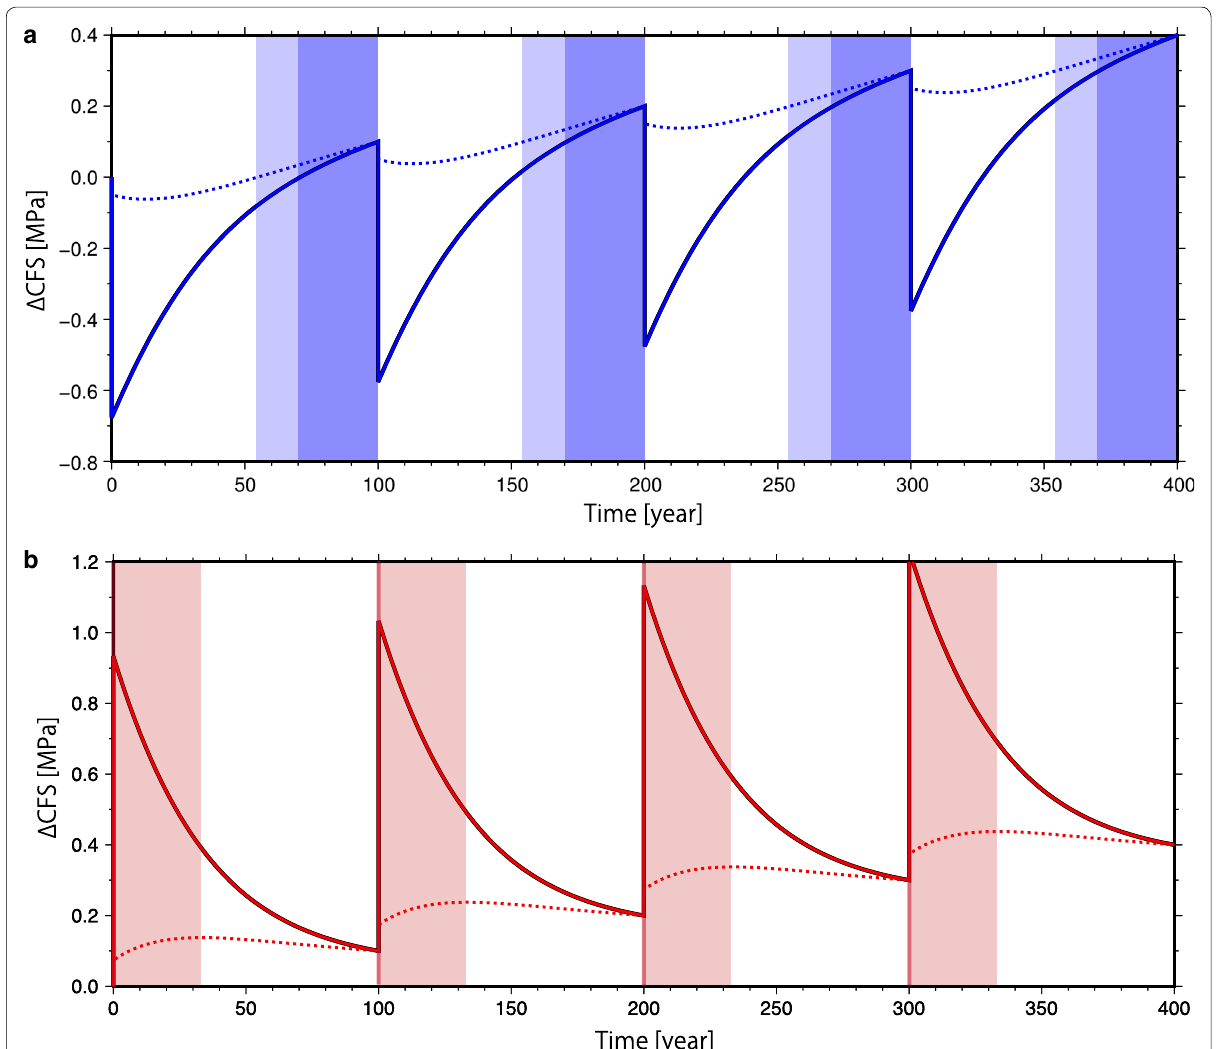
Fig. 3 Examples of the temporal evolution of (cid:31) CFS on an inland fault. The apparent coefficient ( µ ′ ) and the intrinsic loading rate ( �τ intrinsic s /year) in the inland fault are 0.1 and 0.5 kPa/year, respectively. a Case of negative coseismic (cid:31) CFS for dextral faults. The solid and dotted blue lines indicate (cid:31) CFS for faults located 150 km and 300 km from the upper‑edge of the megathrust fault, respectively. The dark and light blue‑shaded areas represent the active periods of these faults, respectively, and b case of positive coseismic (cid:31) CFS for the sinistral faults. The solid and dotted red lines indicate (cid:31) CFS for faults located 150 km and 300 km from the upper‑edge of the megathrust fault, respectively. The dark and light red‑shaded areas represent the active periods of these faults, respectively. However, the dark red‑shaded areas show only during megathrust